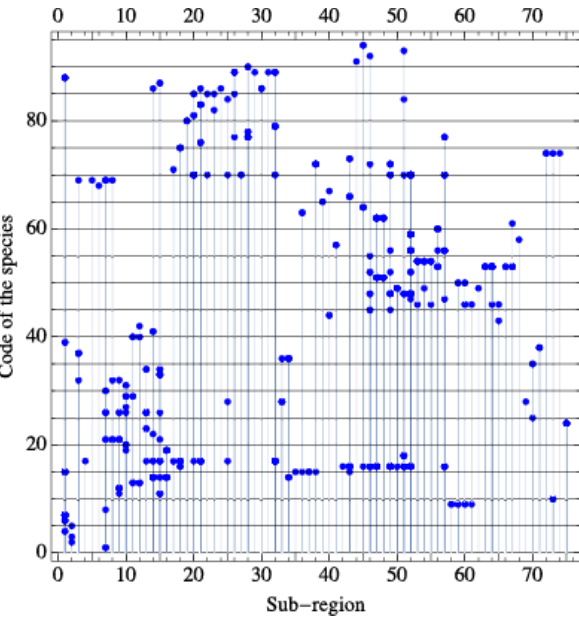
Figure 2. Distribution of the 94 species ( y -axis) in the 75 natural sub-regions ( x -axis) considered in this study. The number of points along a vertical line gives the number of species recorded in the selected sub-region, and the values of those points on the vertical axis identify the species by the codes assigned to them. Given a y -value, by following the horizontal line we identify the sub-regions where the species is recorded. For example, the species (15∆) Hypolobocera bouvieri angulata has been recorded for